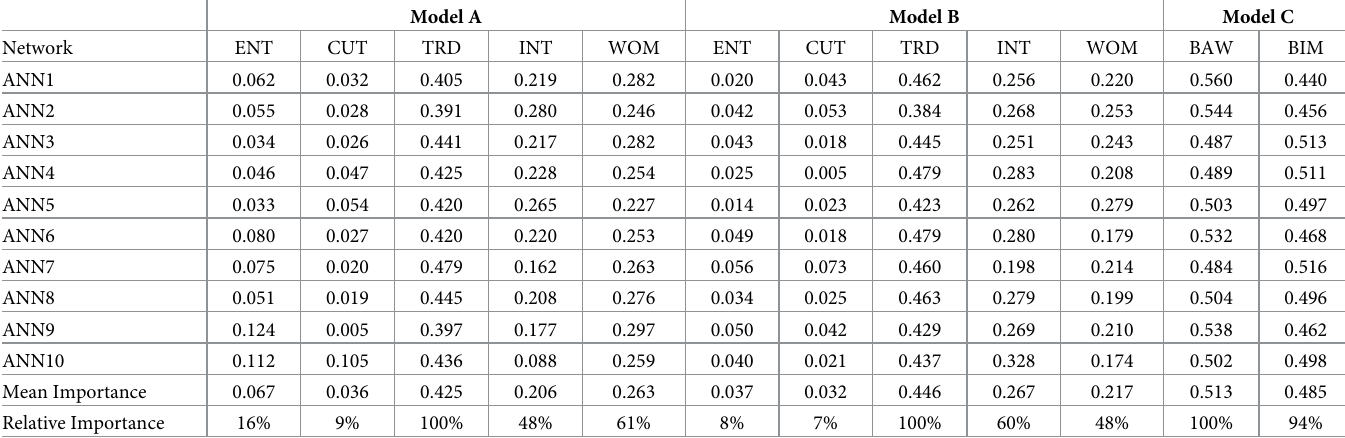
Table 9. Sensitivity